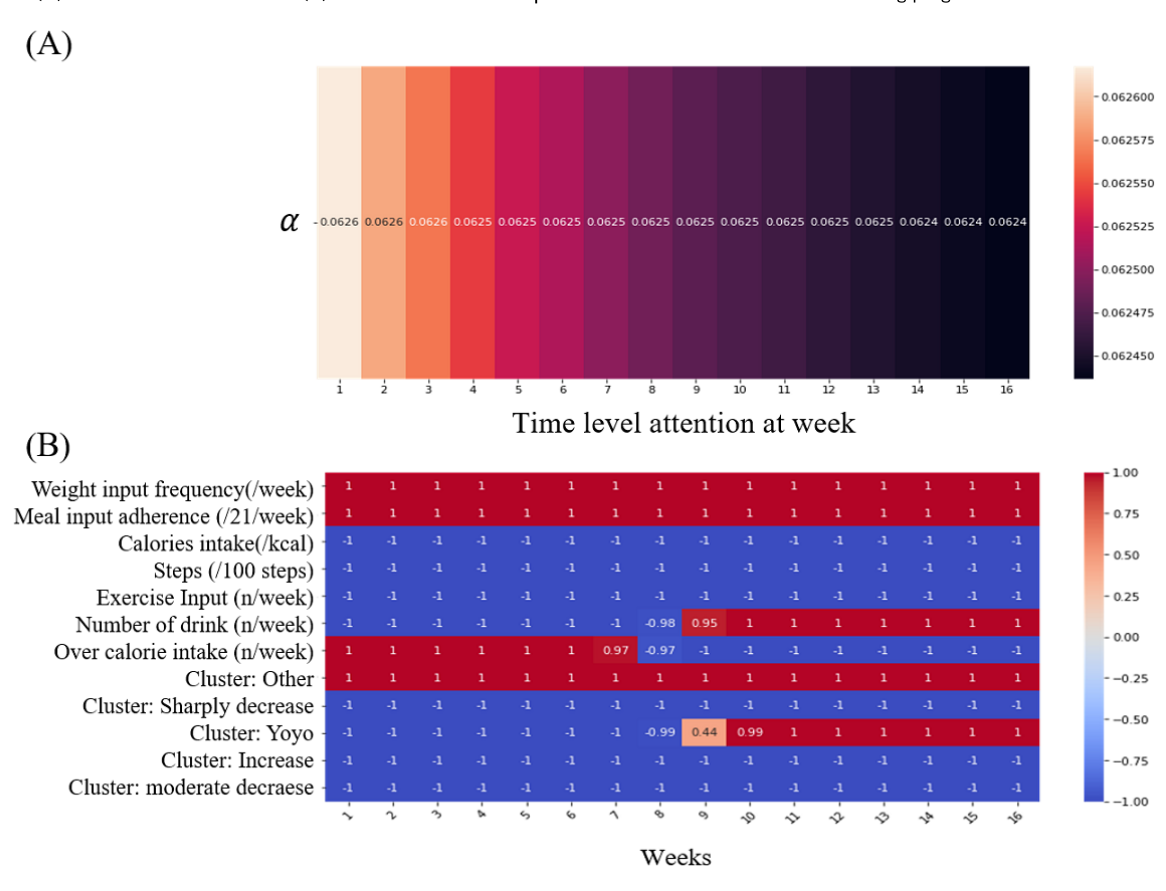
Figure 4. (A) Time-level attention α and (B) variable-level attention β of each variable for the 16-week coaching